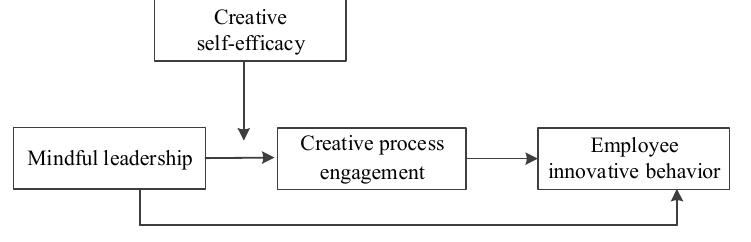
Figure 1. The conceptual